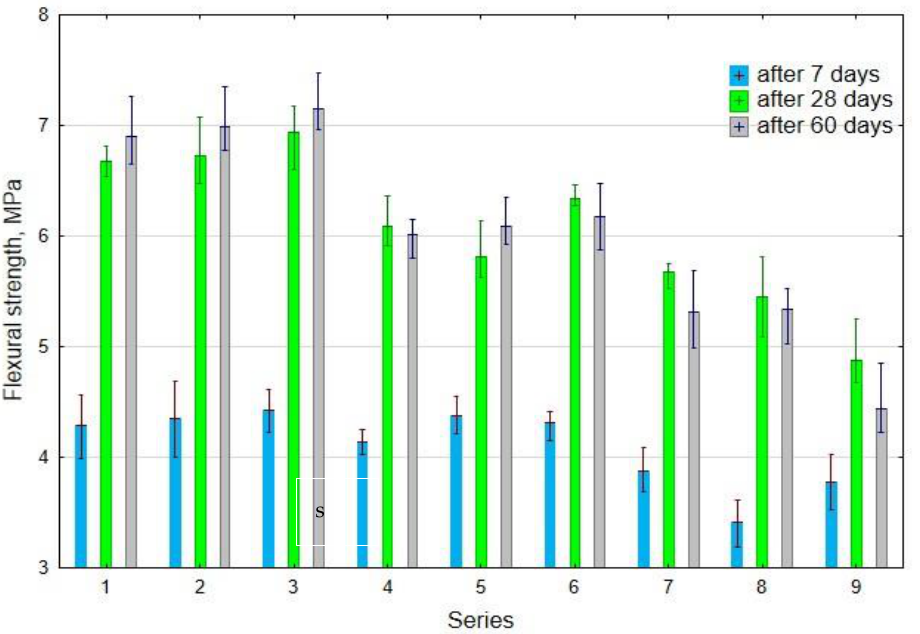
Figure 10. The average test results of the flexural strength of geopolymer mortars with hemp after 7, 28, and 60 days.